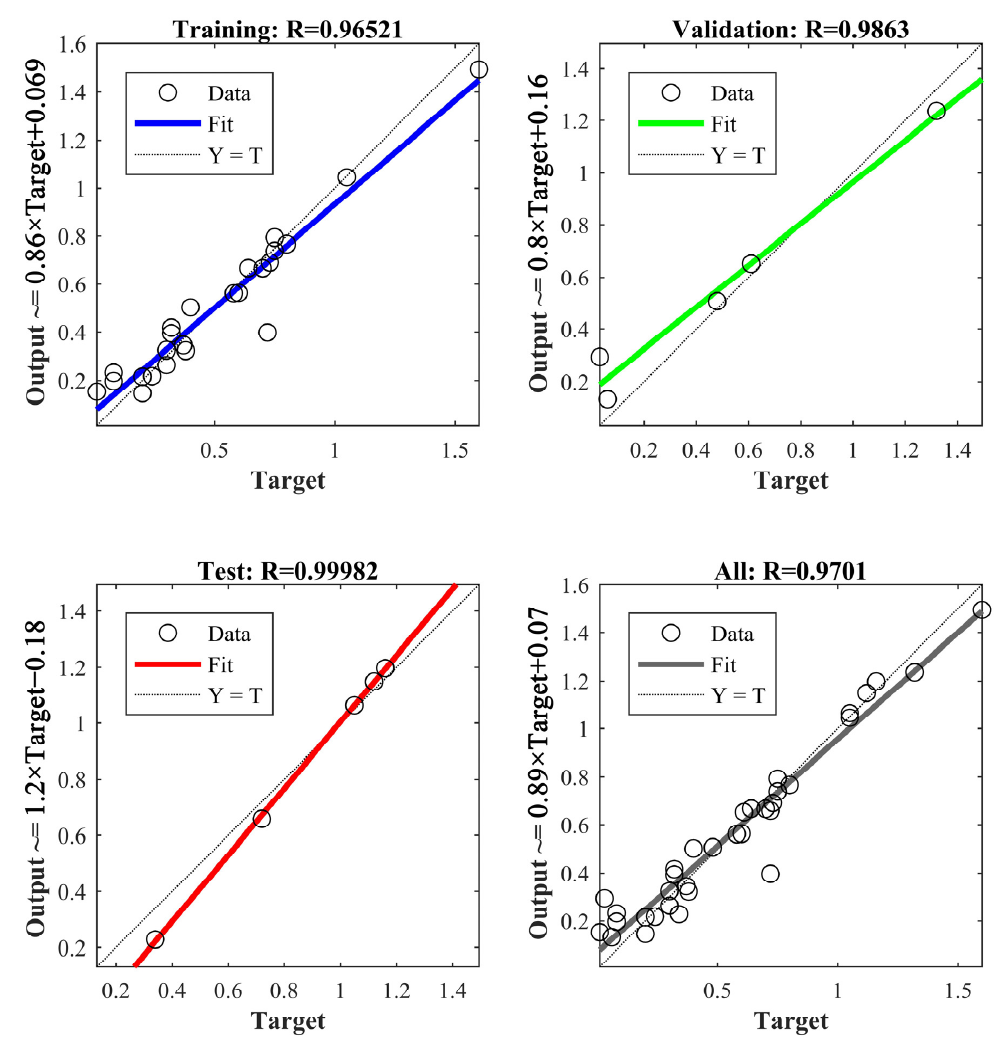
Figure 14. The training and testing results of BP neural network.